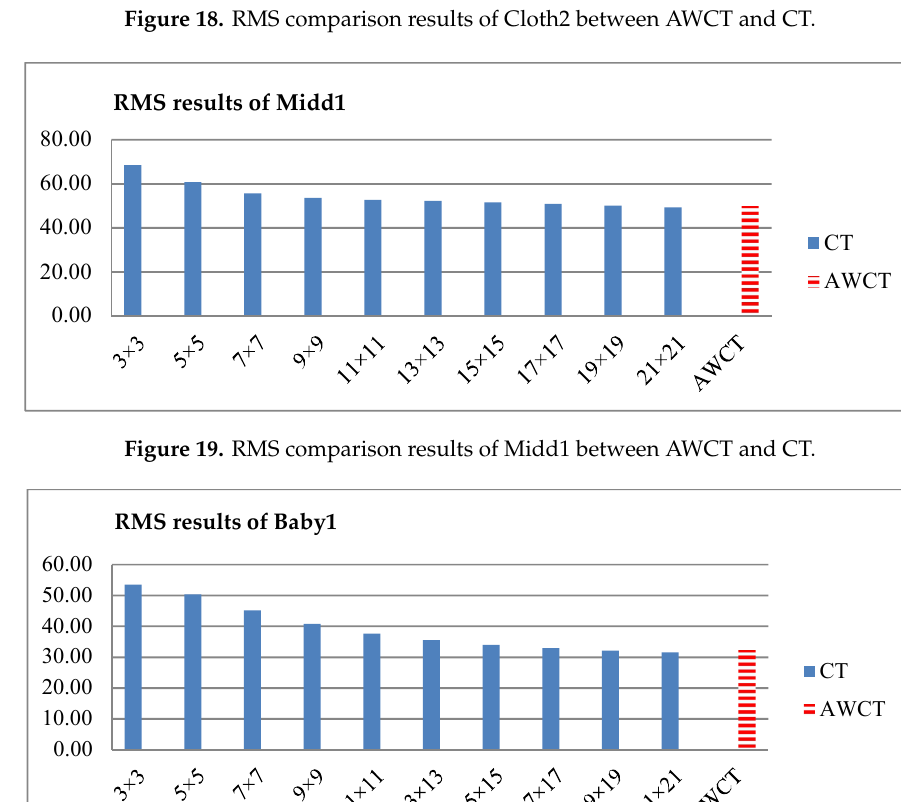
Table 2. Comparison of AWCT and CT.